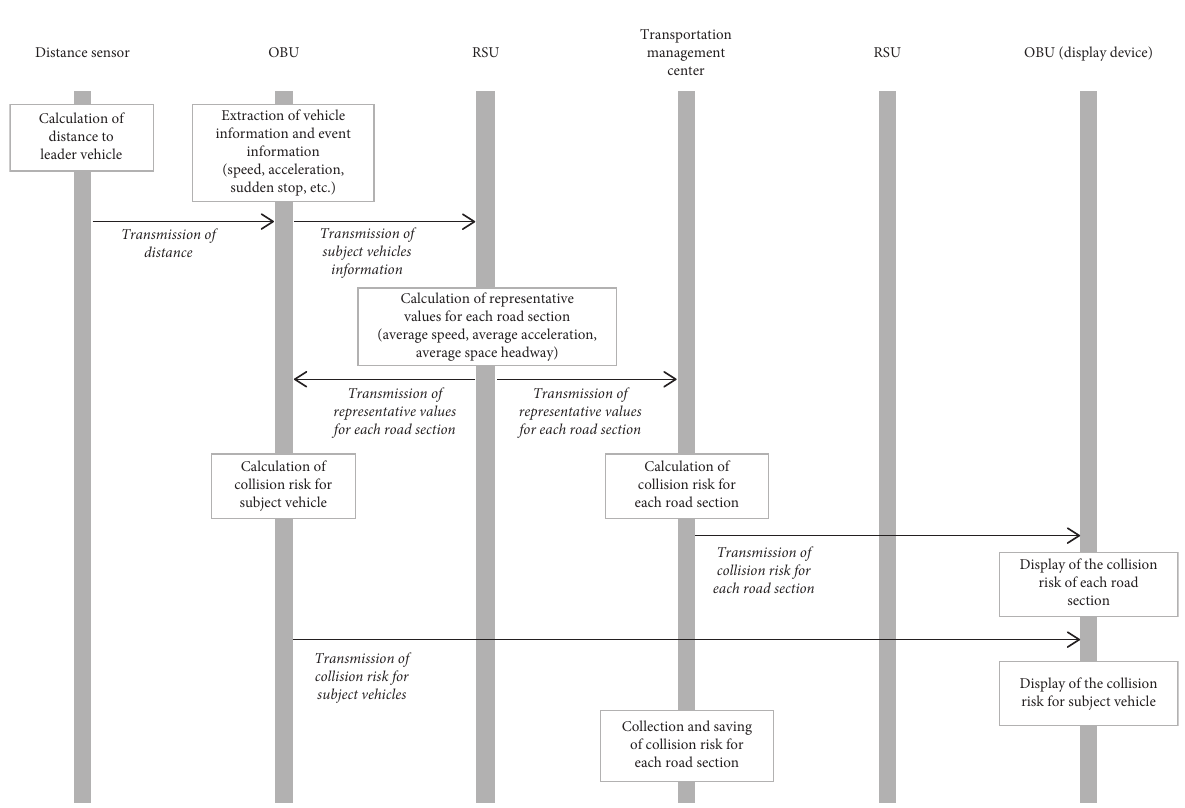
Figure 2: Data flow of the proposed